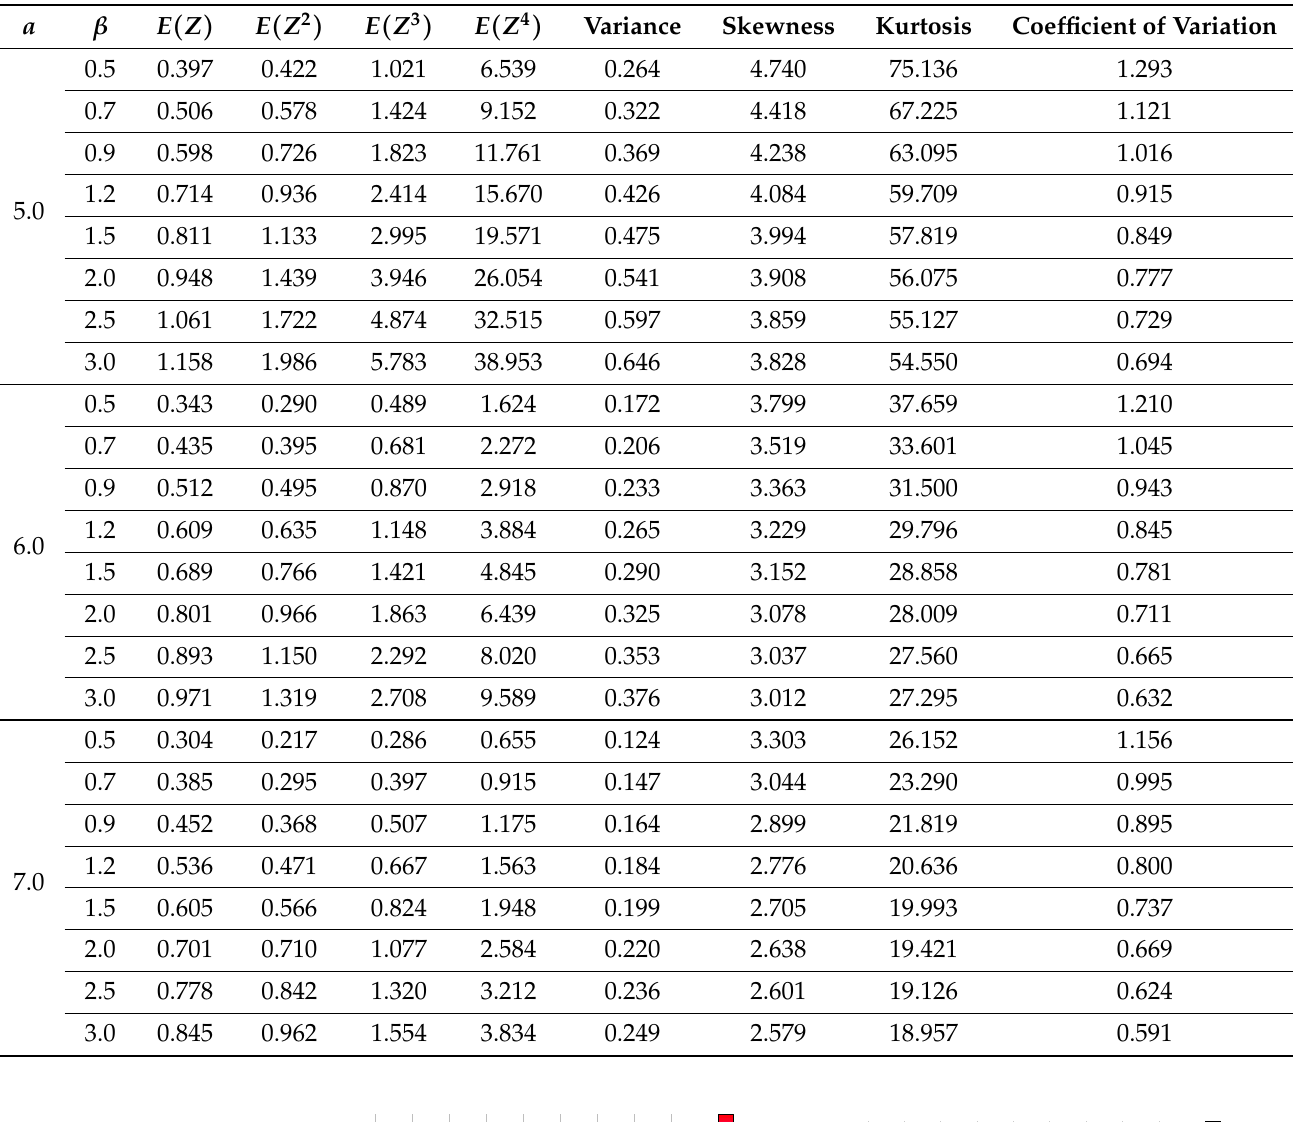
Table 1. Some numerical values of moments.